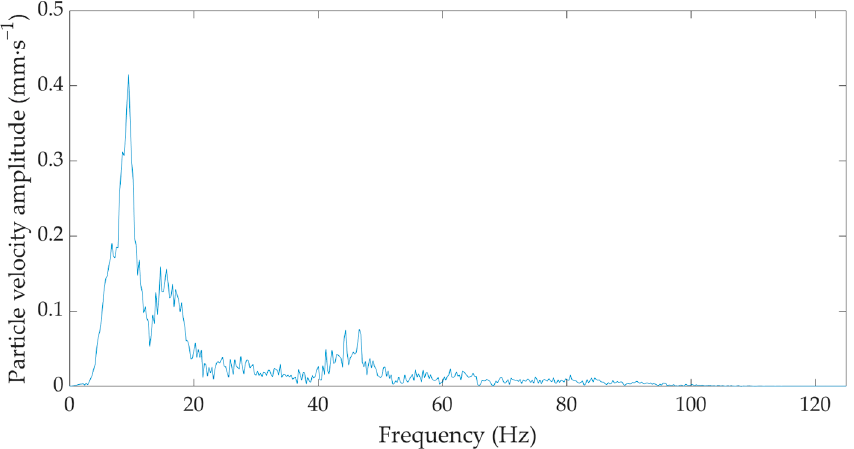
Figure 8. Frequency image of a single hammer strike during the implementation of a gravel pile from the seismic station BRS32—M4.1a measurement diagram.